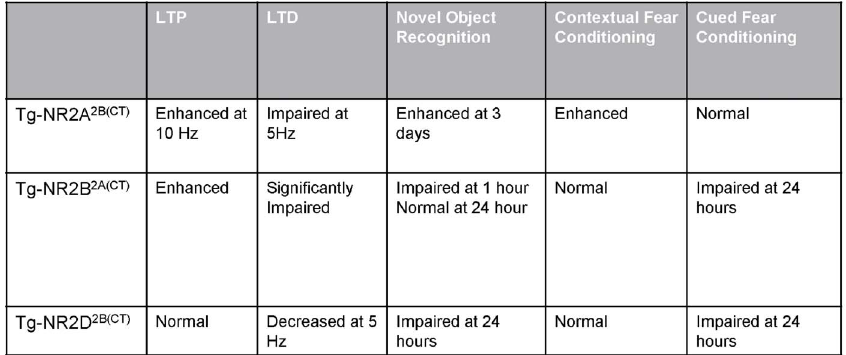
Figure 7. Summary of LTP, LTD and behavioral tasks results. The Tg-NRA 2B(CT) mice had enhanced LTP, as well as enhanced long-term recognition memory and contextual fear conditioning. The Tg-GluN2B 2A(CT) mice have significantly impaired LTD resulting in impaired short-term recognition memory and impaired long-term cued fear conditioning. The Tg-GluN2D 2B(CT) mice have decreased LTD at 5 Hz and impaired long-term recognition memory and long-term cued fear